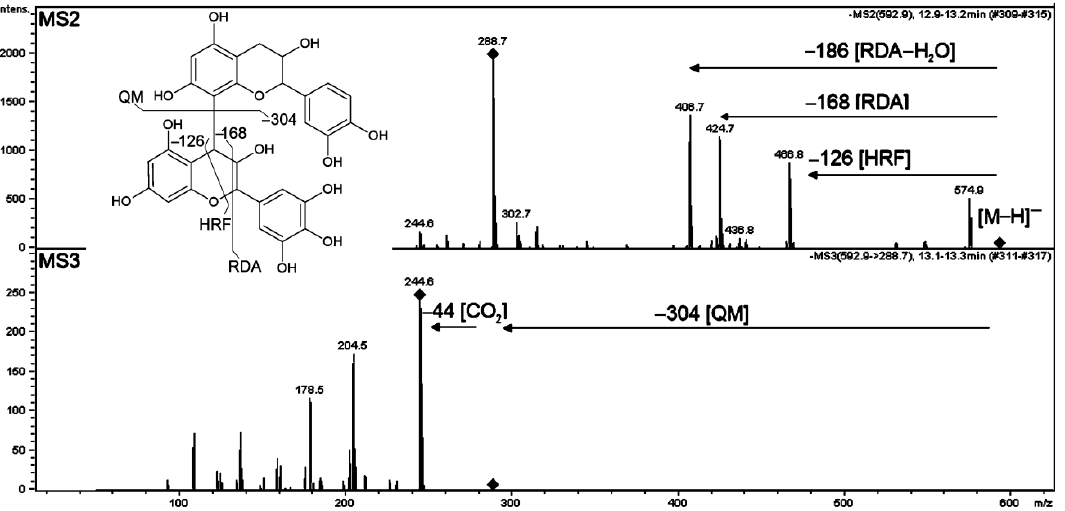
Figure 8. Low-resolution MS2 and MS3 fragmentation spectra obtained in negative ionization supporting identification of compound 15 , prodelphinidin B-type structure. Postulated structure and proposed simplified fragmentation scheme are shown. The product ions subjected to fragmentation in MS3 or MS4 are indicated with turned squares at the ion apexes.